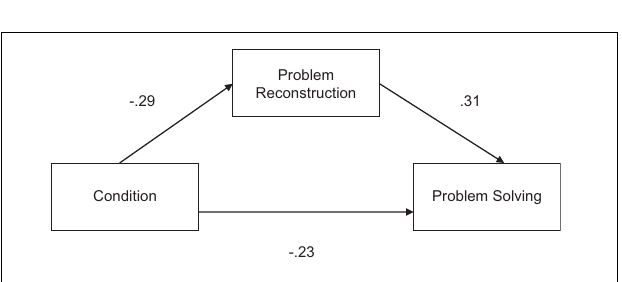
FIGURE 3 | Mediation analysis of the effect of condition on problem solving. Standardized regression coefficients (ß) are